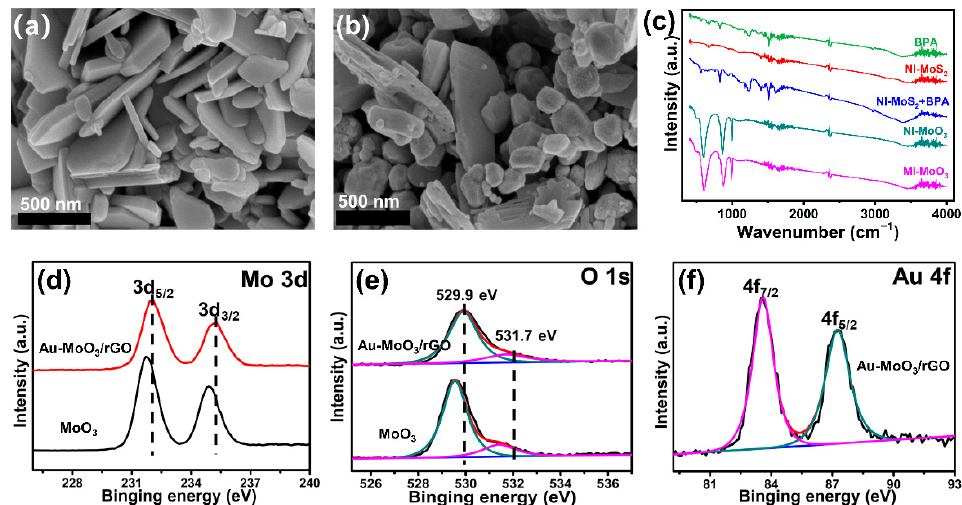
Figure 1. SEM images of MoO 3 ( a ) and Au-MoO 3 /rGO ( b ). ( c ): FT-IR spectra of different samples. XPS spectra of MoO 3 and Au-MoO 3 / r GO samples: Mo 3d ( d ), O 1s ( e ); Au 4f ( f ).